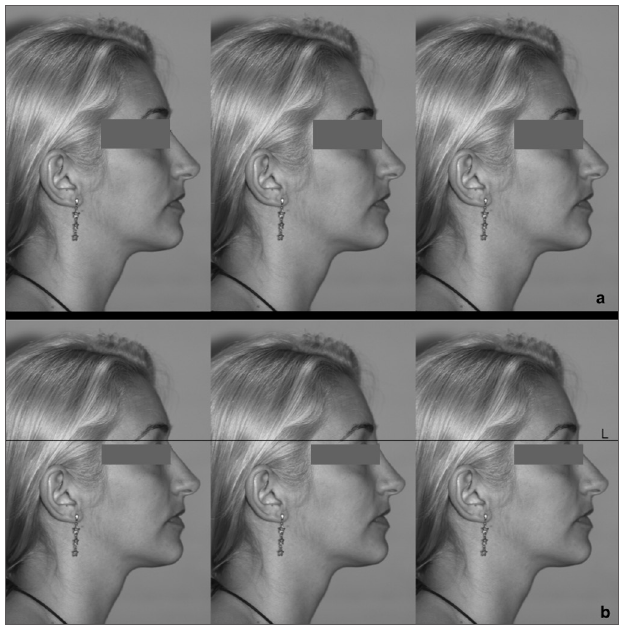
Figure 1. (a) Example of alignment of manipulated images, as shown to interviewees; from left to right: the regular profile, the higher profile, and the lower profile. (b) The same sequence with a reference line (L) representing the regular radix height (regular profile) to show readers the marked difference between the three heights of the nasal radix.